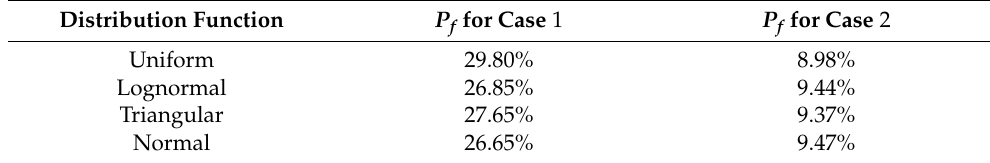
Table 12. P f values for water table level with assumed distribution functions in Case 1 and Case